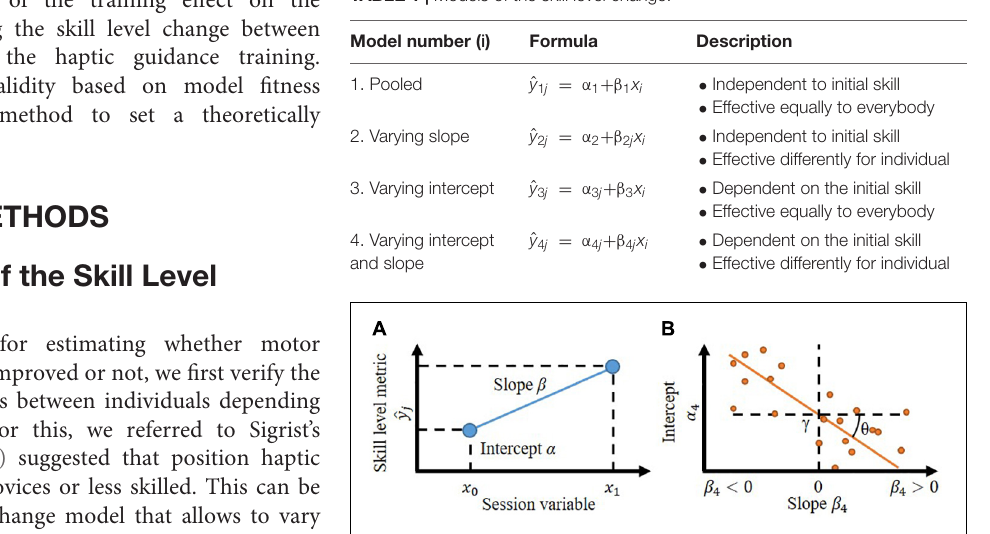
FIGURE 1 | (A) Linear modeling of the skill level change of the participant ( j ). The skill level metric ( ˆ y ) here in this study is the error between the target movement and performed movement. The intercept ( α ) is the initial skill level ( x 0 ). The slope ( β ) represents the change in skill level. (B) The linear relationship between the intercept and slope. Each dot represents a linear model of each participant. The linear relationship allows to set the boundary ( γ ) to divide participants into two groups systematically; those whose skill level improves ( β < 0) or those who decline ( β >